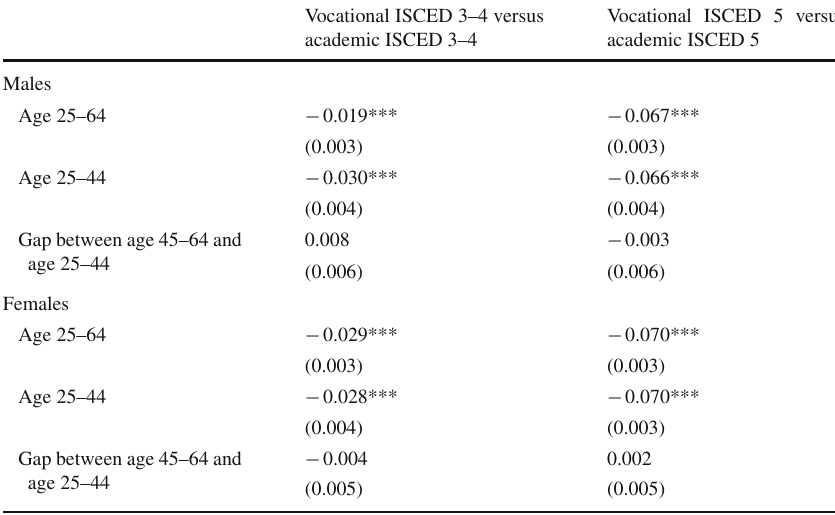
Table 3 Aggregated average treatment effects. Dependent variable: log numeracy score. Source : Calcu- lations based on PIAAC